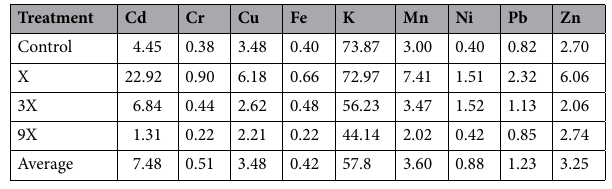
Table 10. Translocation factor.